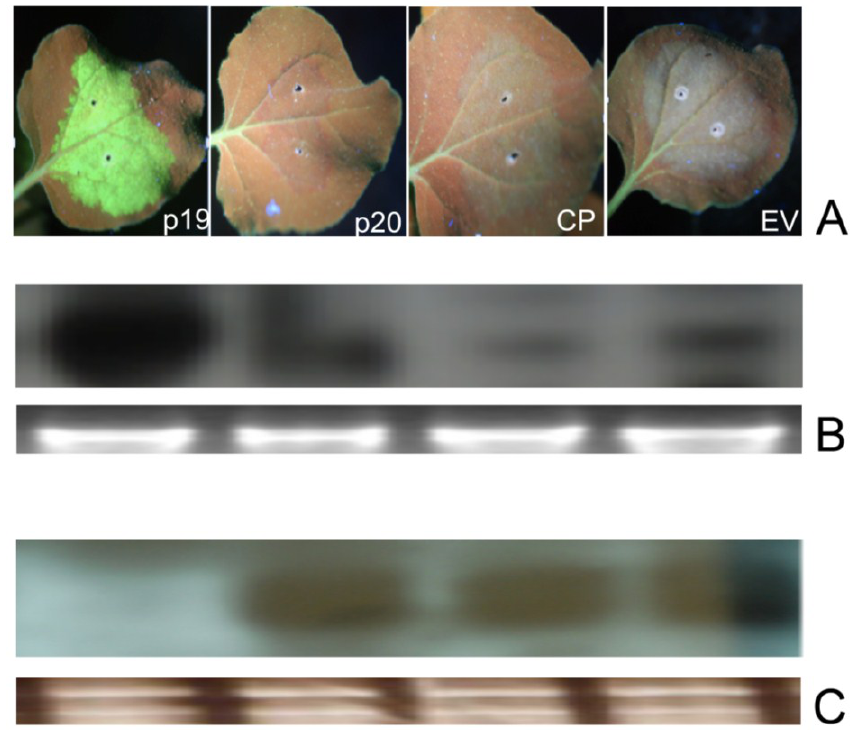
Figure 4. Effect of elevated levels of GFP dsRNAs on PMWaV ORFs on suppression of GFP local silencing. ( A ) Leaves co-infiltrated with A. tumefaciens cultures harboring constructs pBIC-35S-dsGF plus pBIC-35S-sGFP with PMWaV-2 p20, CP, 35S-EV, or 35S-p19 in WT N. benthamiana . 35S-p19 and 35S-EV are positive and negative controls respectively. Northern blot analysis of GFP mRNAs ( B ) and siRNAs ( C ) isolated from leaves infiltrated with the constructs depicted in the images. The images were photographed at 3 dpi. Loading controls for GFP mRNAs and siRNAs were estimated by ethidium bromide staining of ribosomal